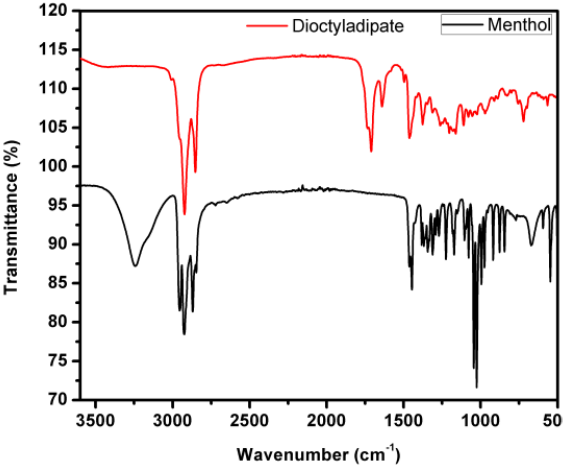
Figure 2: FT - IR spectrum of the dioctyladipate (red) and menthol (black).